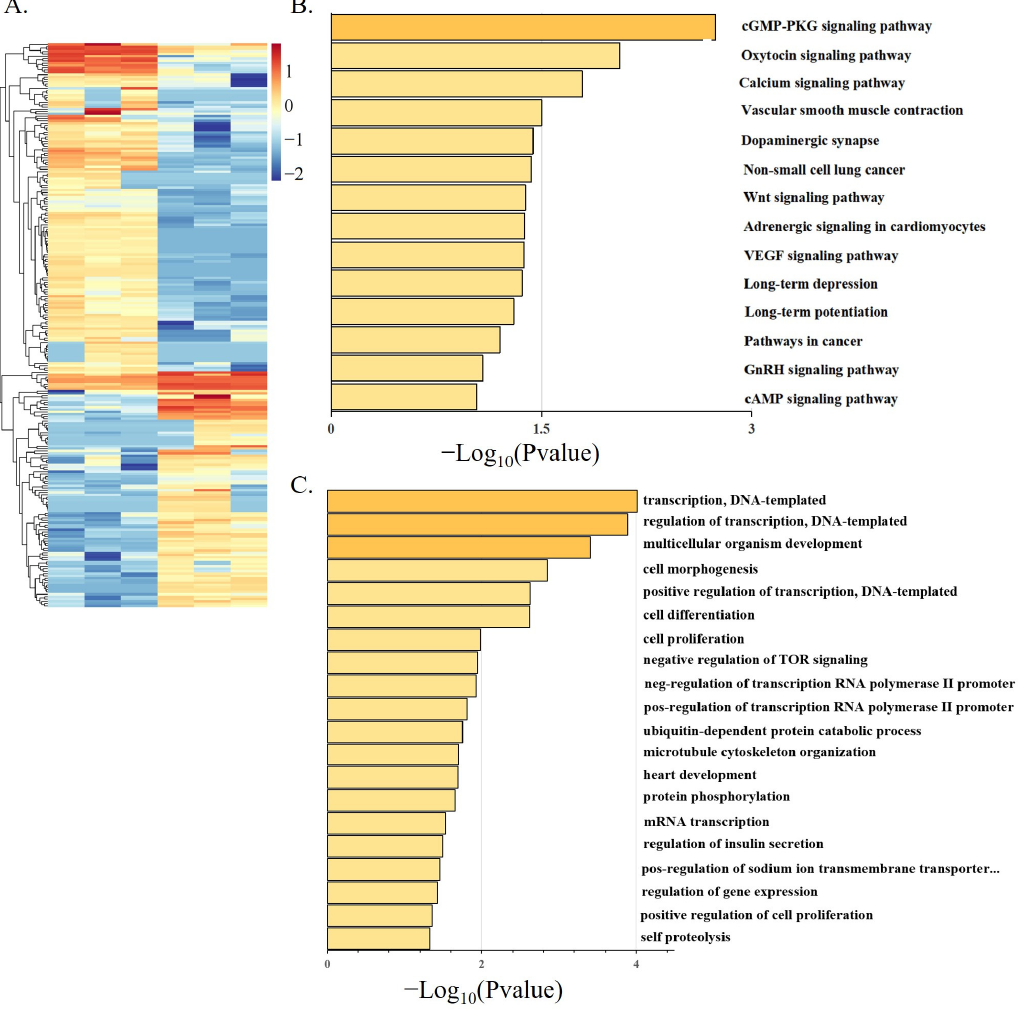
Figure 5. Differential expression analysis of LncRNA during Shitou goose myoblasts differentiation. ( A ) Heat map of DE-lncRNA. The heatmap was constructed using Log10 (FPKM) values.; ( B ) enriched KEGG pathway of DE-lncRNAs; ( C ) GO enrichment of DE-lncRNAs.